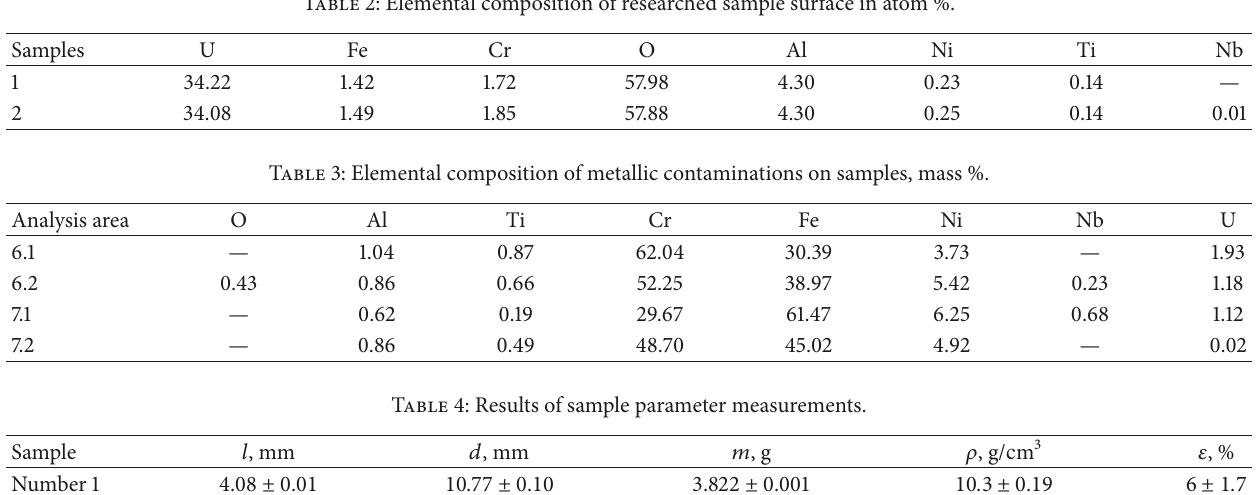
Table 2: Elemental composition of researched sample surface in atom %.